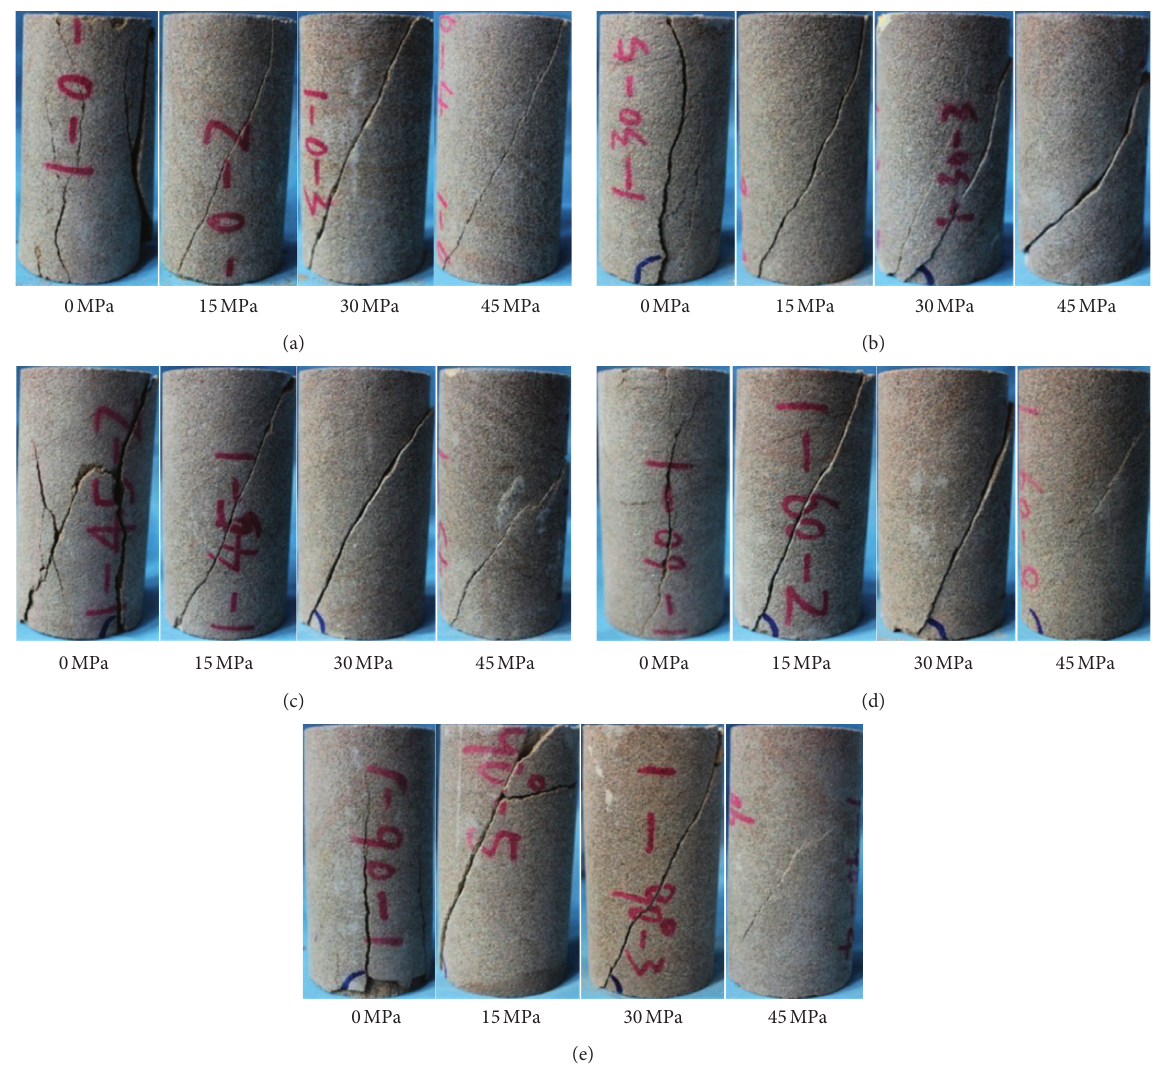
Figure 8: Fracture morphology of tight sandstone samples under different confining pressure. (a) Dip angle α � 0 ° . (b) Dip angle α � 30 ° . (c) Dip angle α � 45 ° . (d) Dip angle α � 60 ° . (e) Dip angle α � 90 °